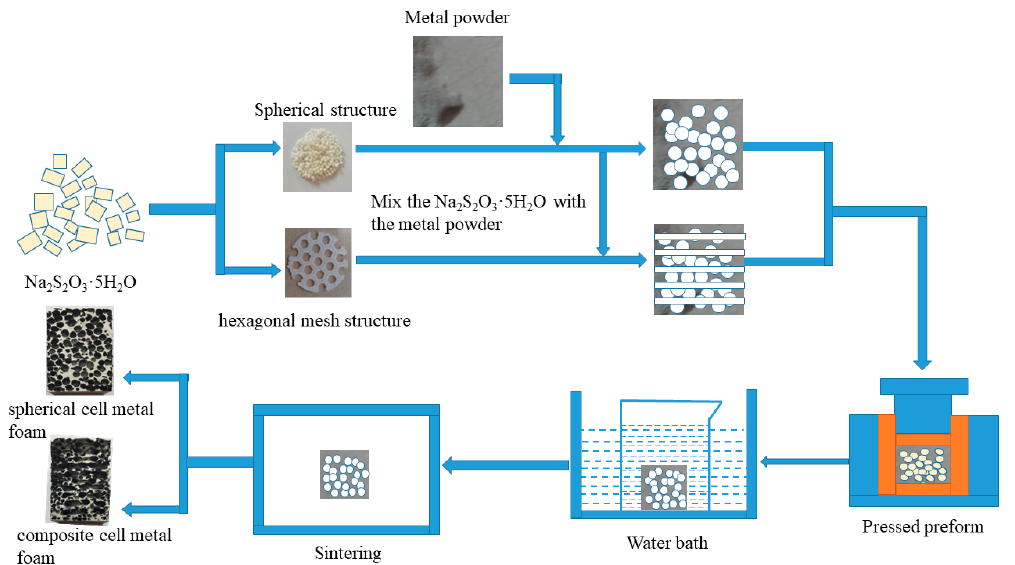
Figure 1. The process of preparing metal foam with Na 2 S 2 O 3 ·5H 2 O as space holder. (The compression pressure is 370 Mpa).